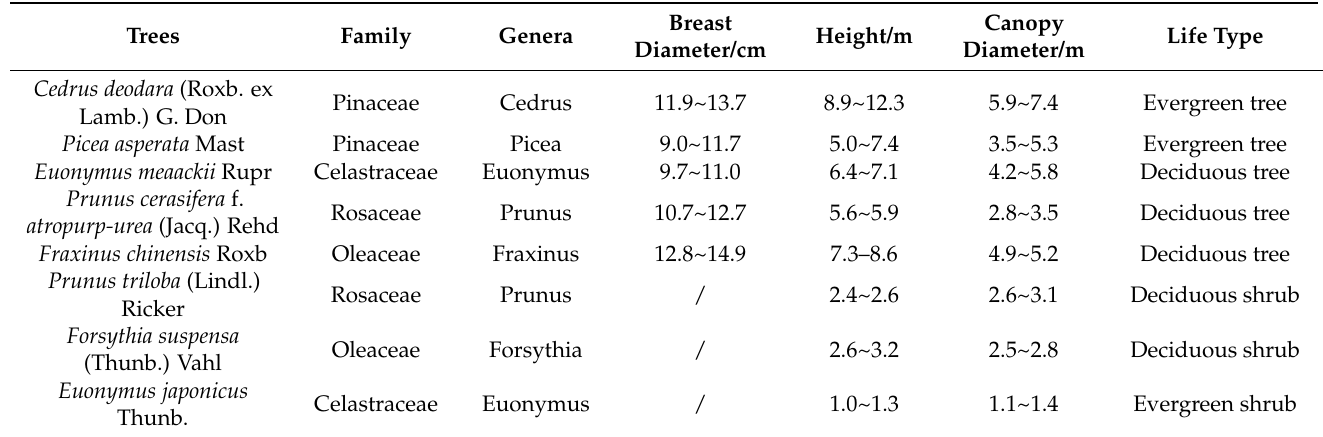
Table 2. Growth indicators of eight landscape